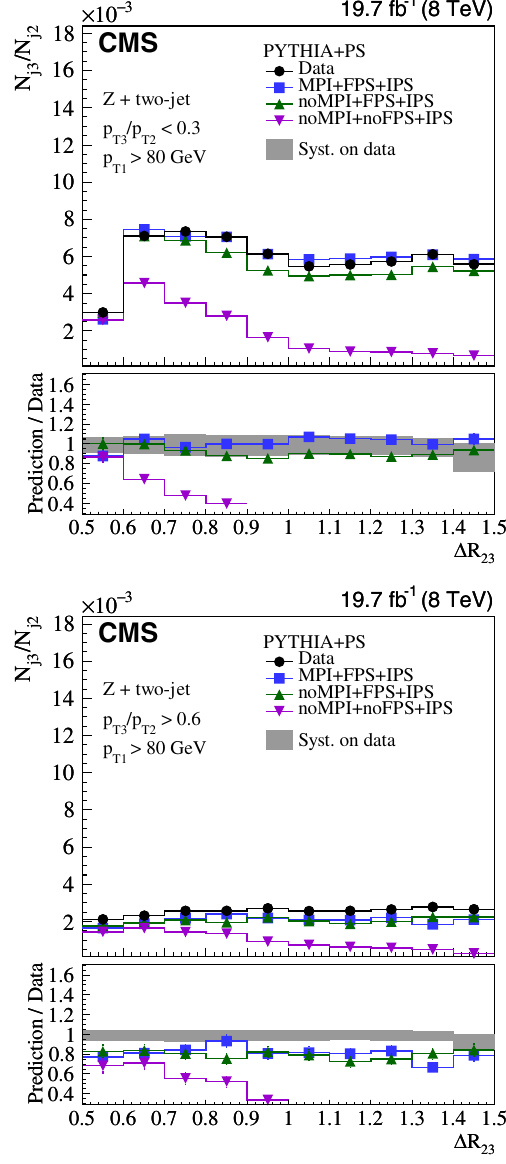
√ Fig. 9 Z + two-jet events at s = 8TeV and comparison to the- √ Fig. 8 Z + two-jet events at s = 8TeV compared to theoretical oretical predictions from pythia 8 without initial-state parton show- predictions from pythia 8 without initial-state parton showers (IPS), ers (IPS), final-state parton showers (FPS), and MPI: (upper) Δ R 23 final-state parton showers (FPS), and MPI: (upper) p T3 / p T2 for small- for soft radiation ( p T3 / p T2 < 0 . 3), (lower) Δ R 23 for hard radiation angle radiation ( Δ R 23 < 1 . 0), (lower) p T3 / p T2 for large-angle radia- ( p T3 / p T2 > 0 . 6). tion ( Δ R 23 > 1 . 0) emission at large p T3 / p T2 both in the collinear and large- angle regions, for all of the tested models. Contribution from tt anddibosons productionmaypartiallycover